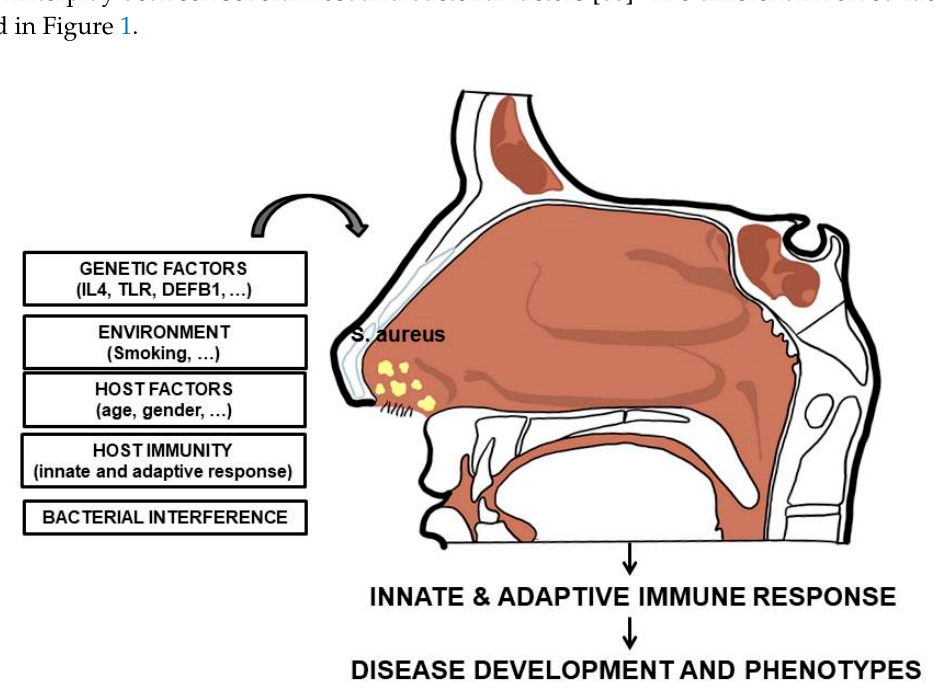
Figure 1. Host and bacterial factors influencing S. aureus nasal colonization.